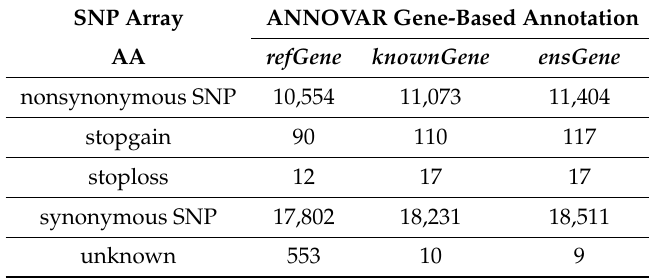
Table 1. Summary of number of variants with different functions using three gene annotation databases for African American